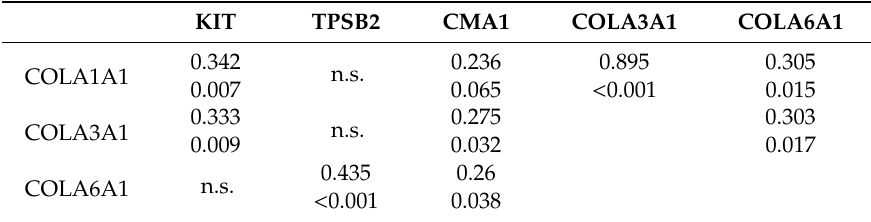
Table 2. Intercorrelation between VAT-MC and collagens’ gene expression in the Beer-Sheva cohort ( n = 65). n.s, not significant. Values are r and p value (upper and lower line respectively) of Spearman’s correlations. CMA1: mast cell chymase 1, TPSB2: mast cell tryptase beta II, COLA1A1: collagen type